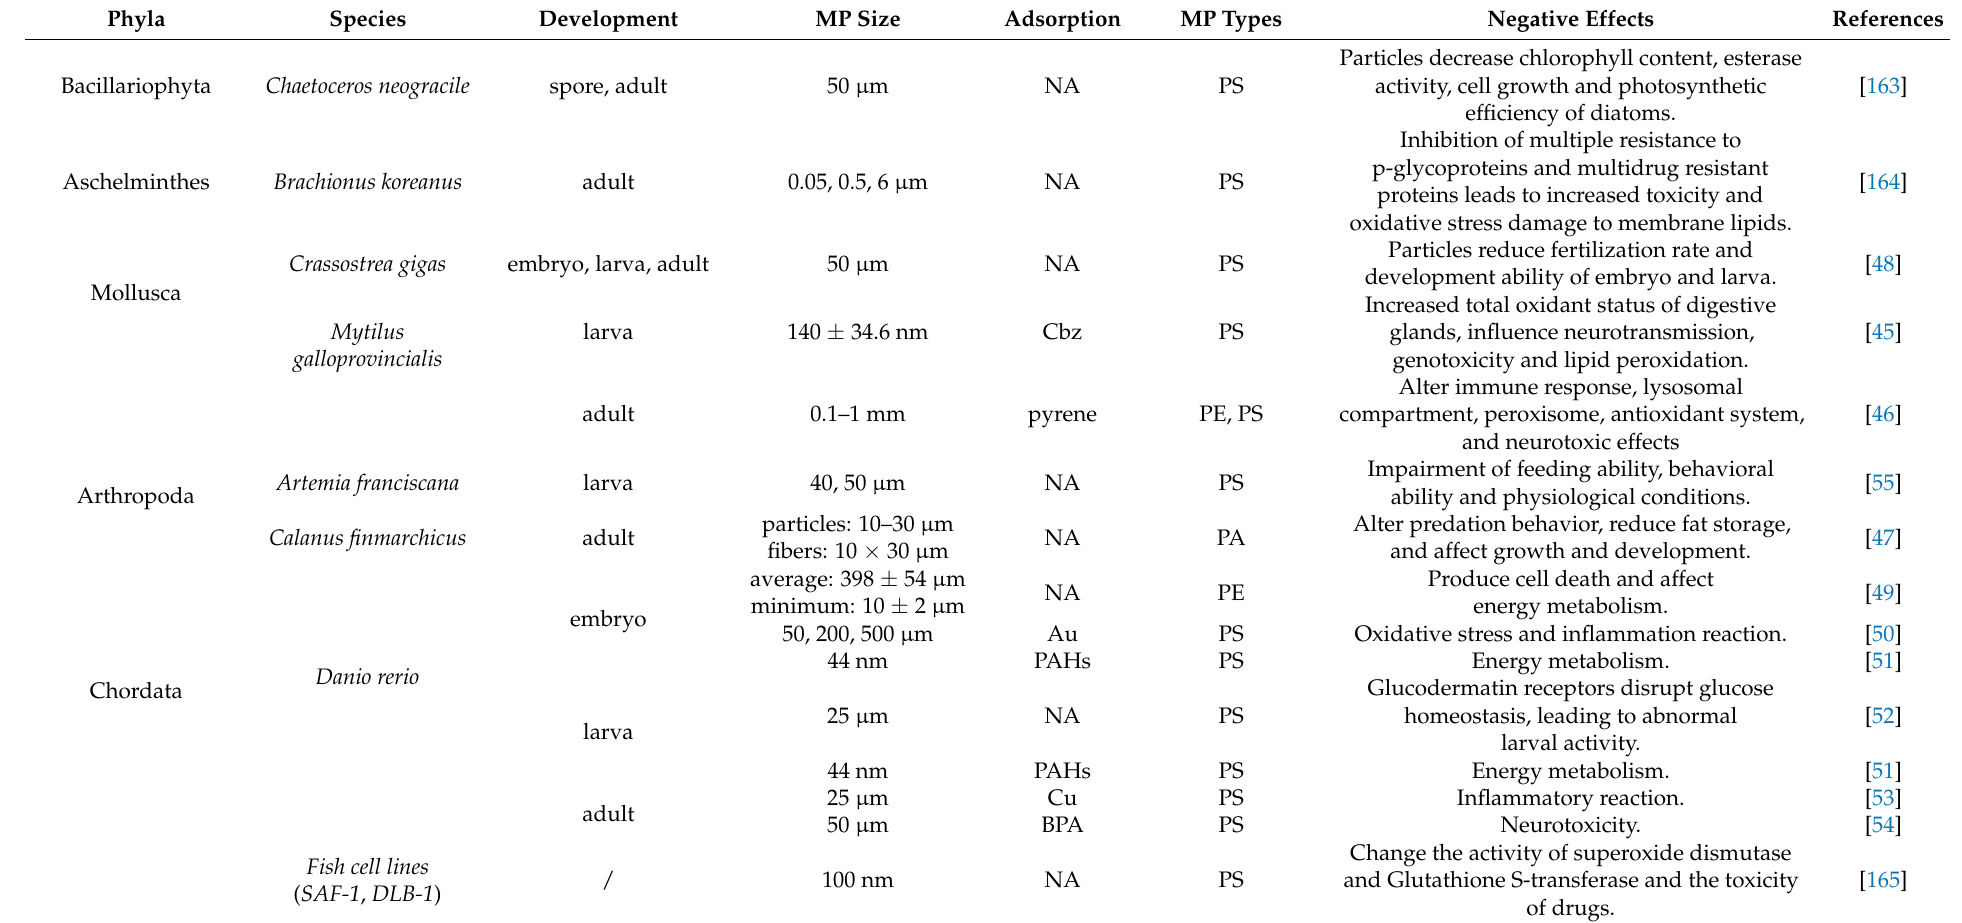
Table 2. Effects of microplastics and nanoplastics on marine